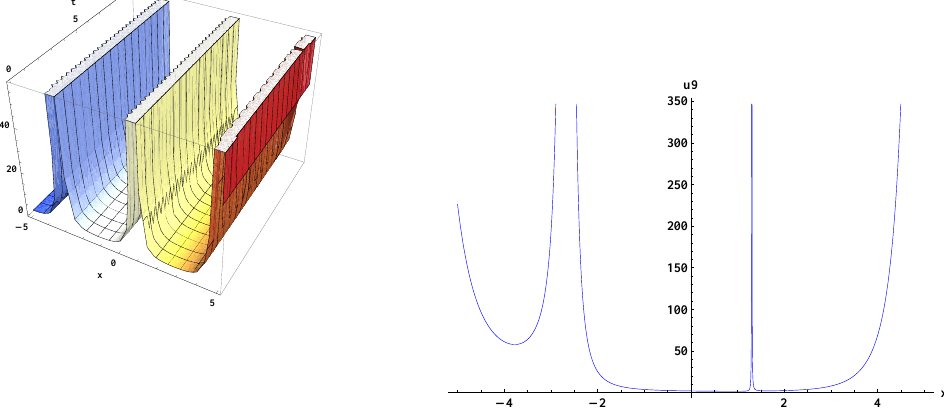
Figure 9. Singular periodic wave solution (26) ( left ) and its projections at t = 0 ( right ), when A 1 = 0.4, A 2 = 0.6, µ = −0.7, λ = 0.9, k = 0.2, δ = 1, and y = 0.5.